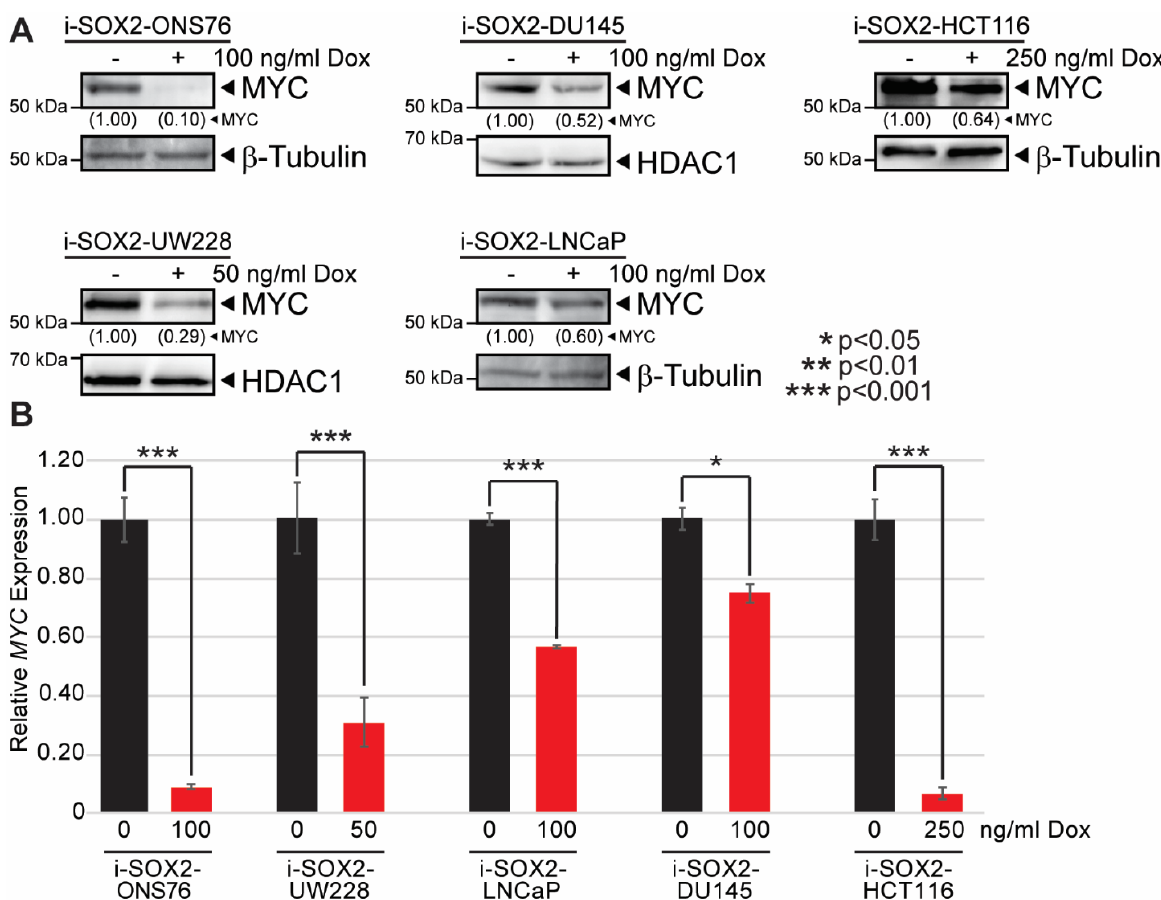
Figure 2. Elevating SOX2 downregulates MYC protein and mRNA in multiple tumor types. ( A ) Western blot analysis of MYC protein levels in i-SOX2 tumor cell lines after 48 h culture in the presence or absence of Dox at the indicated concentrations. ( B ) RT-qPCR analysis of MYC mRNA expression in i-SOX2 tumor cell lines after 48 h culture in the presence or absence of Dox at the indicated concentrations. Error bars represent standard deviation. * p < 0.05, *** p < 0.001.